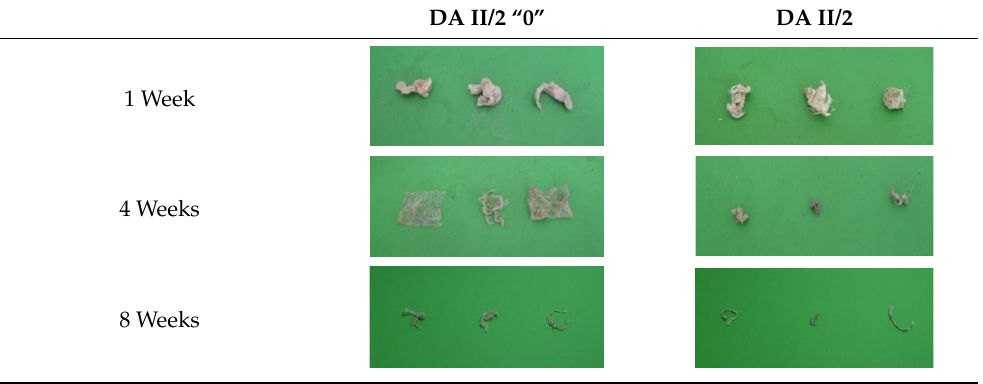
Table 3. The photo-documentation of the biodegradation process (Sample DA